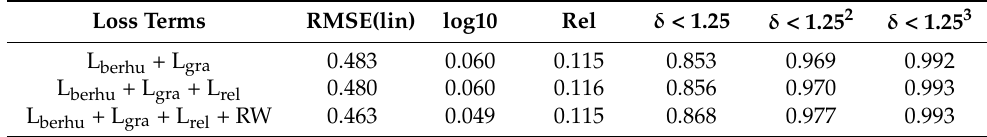
Table 5. Quantitative evaluation results of different loss terms.